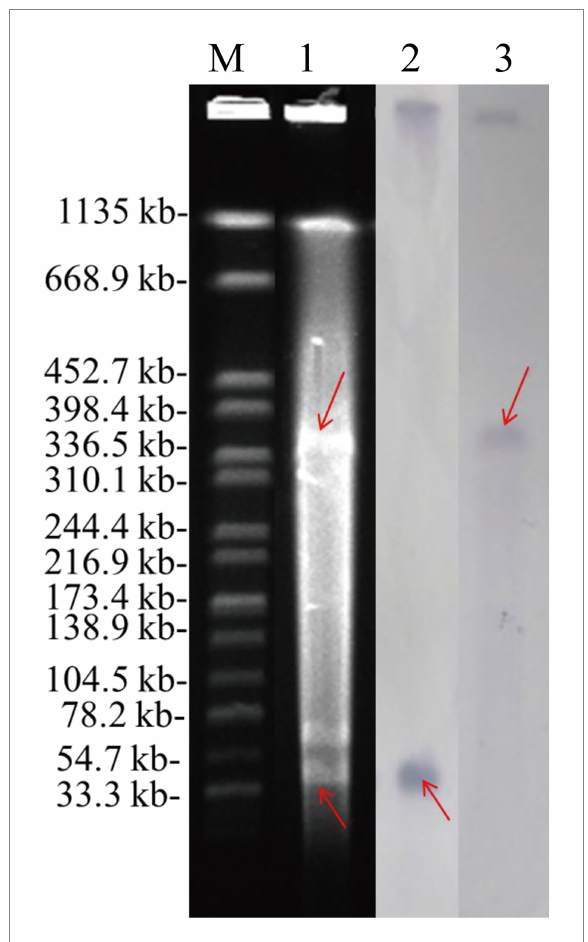
FIGURE 1 S1-PFGE and Southern hybridization of mcr-1 and bla NDM genes in the Escherichia coli strain EC15-50. The arrows indicate the locations of the plasmids hybridized to the mcr-1 and bla NDM probes. M, reference standard strain H9812 restricted with XbaI ; Lane 1, E. coli EC15-50; Lane 2, the plasmid hybridized to the bla NDM -probe; Lane 3, the plasmid hybridized to the mcr-1